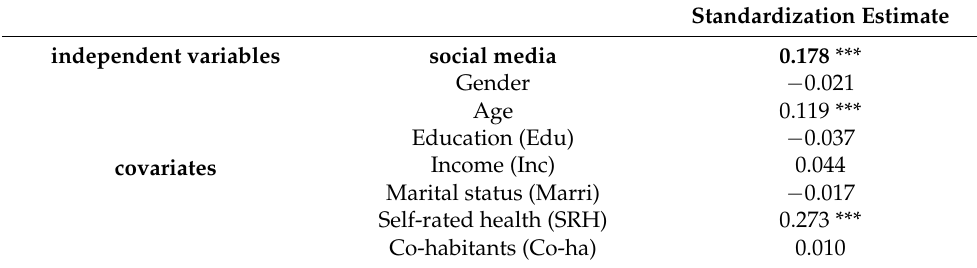
Table 4. Standardization coefficient and significance of the overall model.